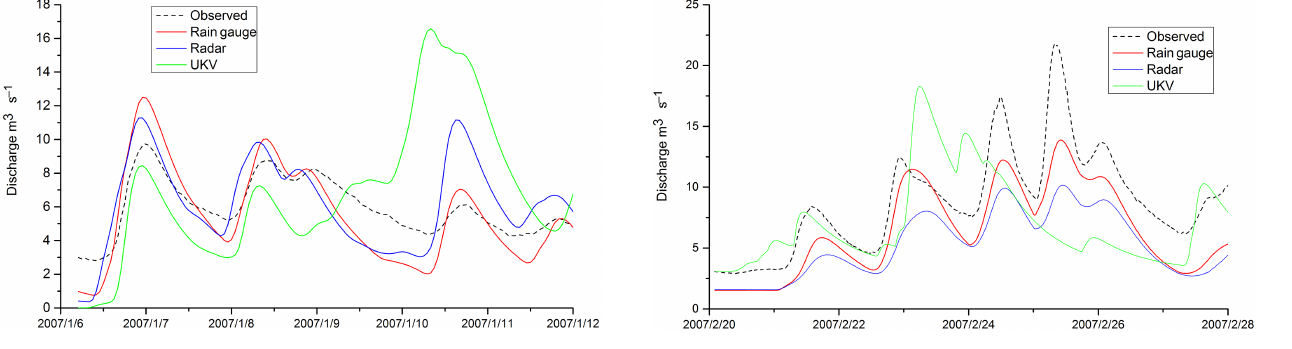
Figure 8. The comparison of flow simulation in HYPE (event February